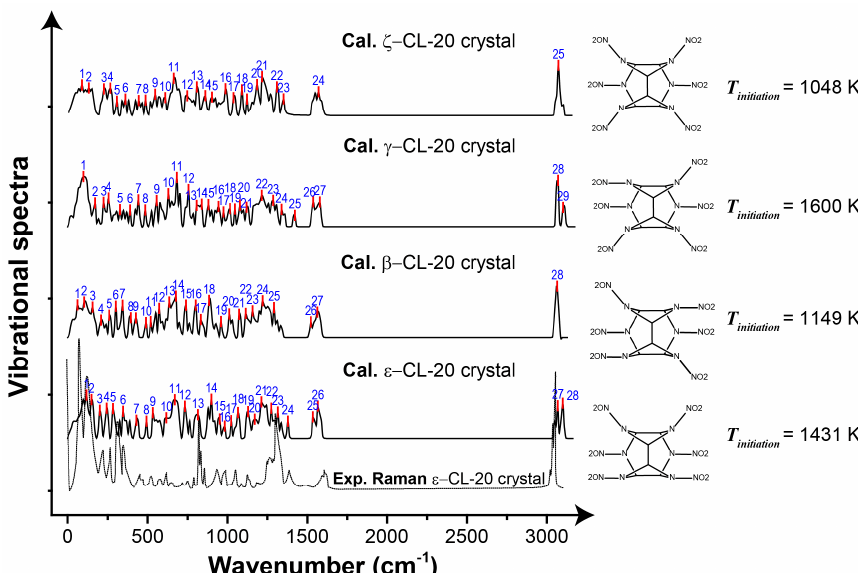
Figure 5. Vibrational spectra for ε , β , γ and ζ polymorphs of CL-20 crystals. The characteristic peaks of the vibrational spectra are marked by vertical red lines and are indexed by blue texts. For each of the four polymorphs, the molecular conformation and the temperature ( T initiation ) when the crystal starts to decay under shock are also shown.